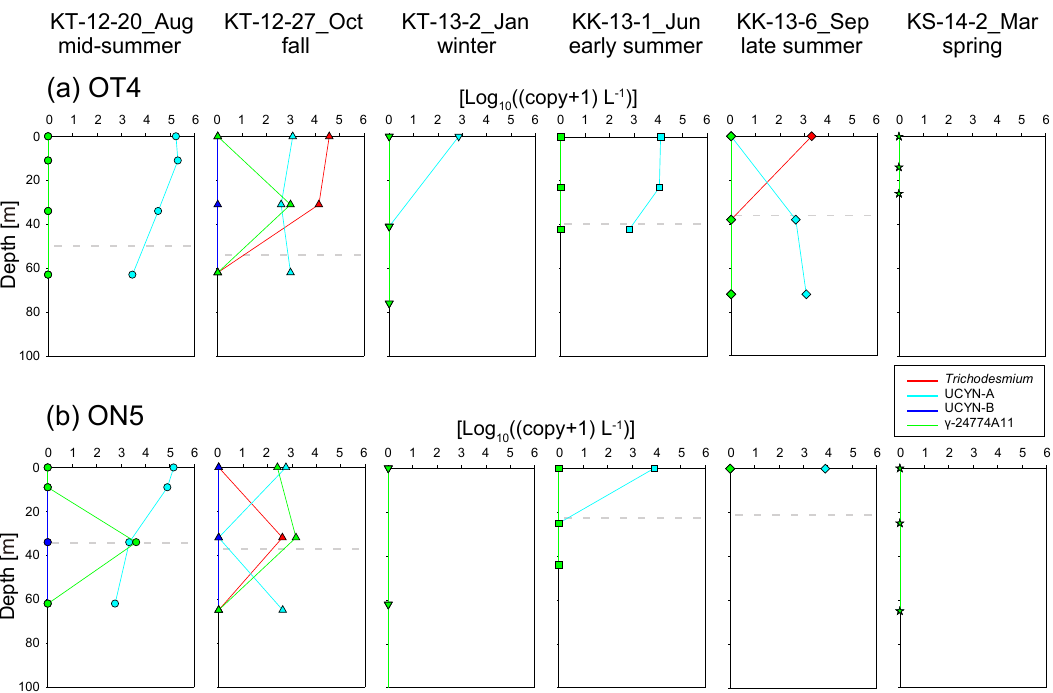
Figure 8. Time-series variations in the vertical profiles of Trichodesmium (red), UCYN-A (light blue), UCYN-B (blue), and γ -24774A11 (green) [Log 10 ((copy + 1)L − 1 ) ] at Stns. (a) OT4 and (b) ON5. The horizontal dashed line indicates the nitracline